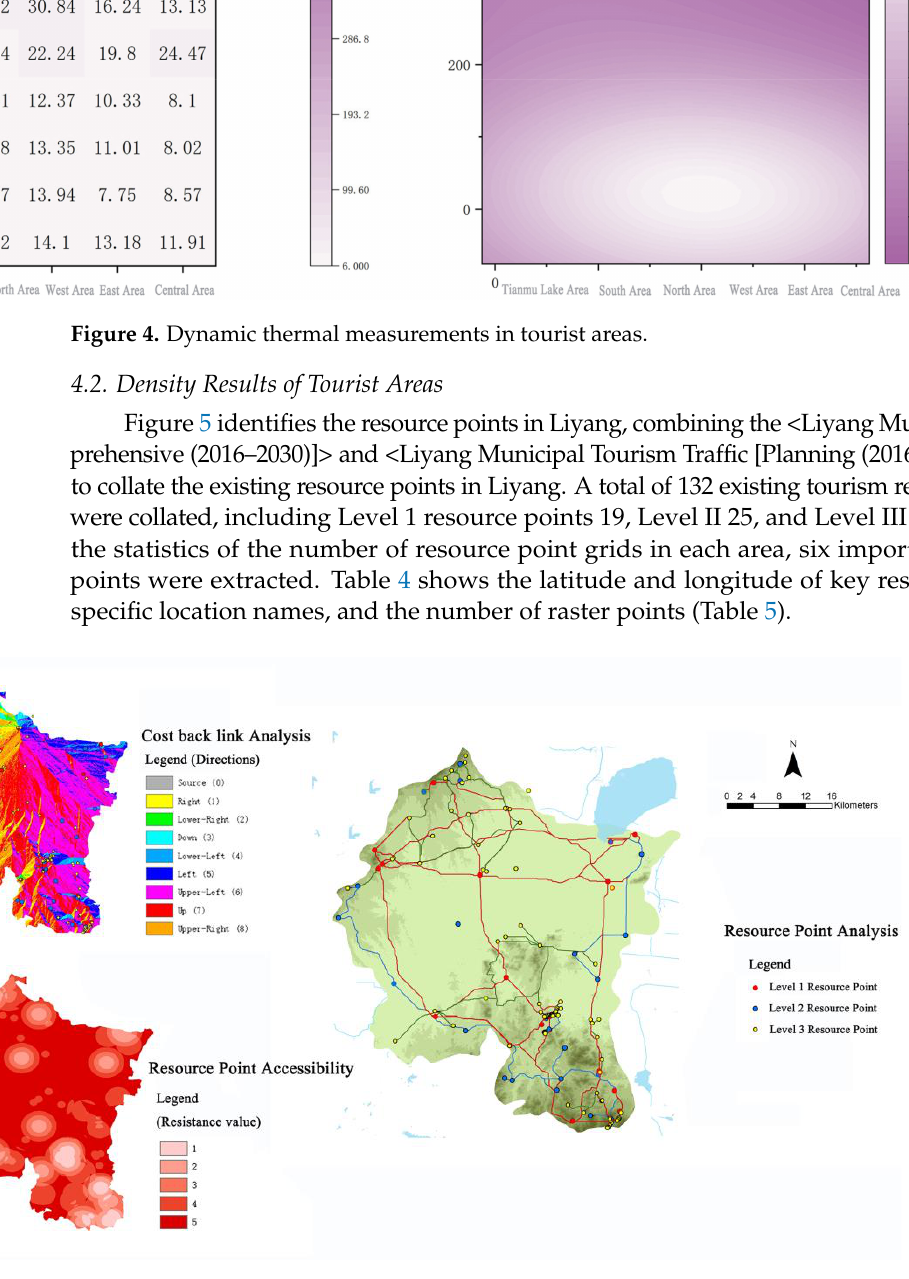
Figure 5. Regional Important Resource Point Analysis Map. Table 5. Coordinate identification of key resource points.